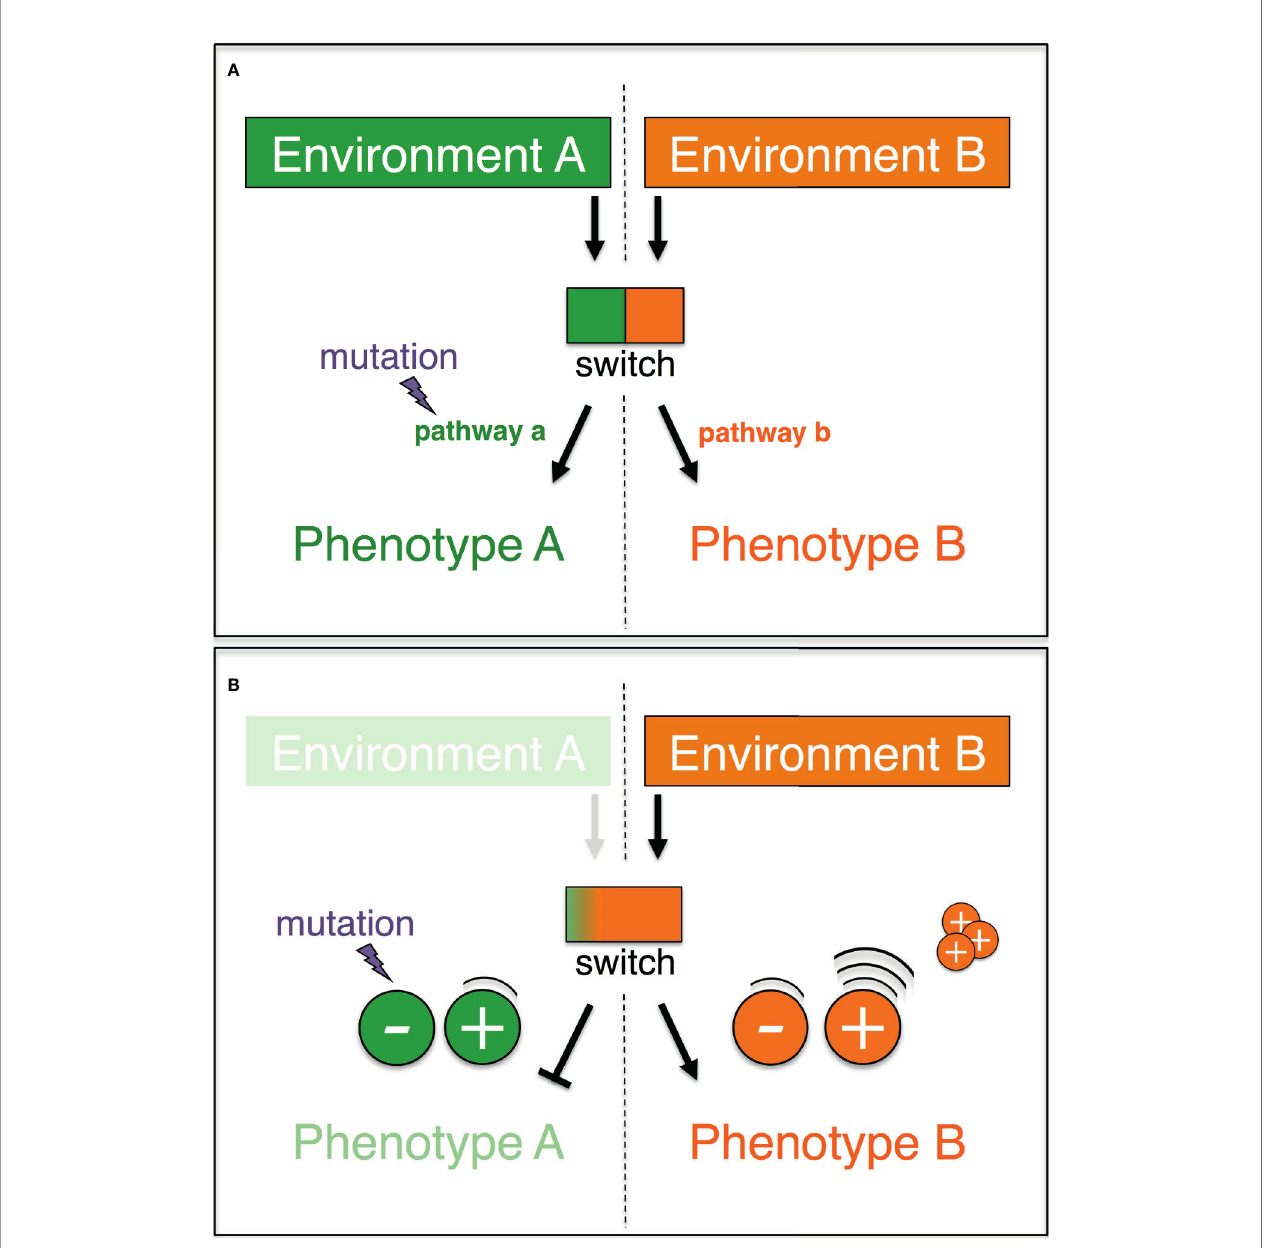
FIGURE 1 | Graphic representation of the plasticity-relaxation-mutation model (Hughes, 2012) and its expanded version (this study). (A) A genetic switch controls the expression of two alternate pathways (a, b) leading, respectively, to two alternate phenotypes (a, b) in response to two different environments (a, b). When environment A is no longer encountered by the organism/cell, there is no longer purifying selection against mutations that eliminate pathway a (modi fi ed after Hughes, 2012). (B) If phenotype A and phenotype B are antagonistically regulated, then the negative molecular regulators of the disfavored phenotype A are redundant and preferentially accumulate mutations. The positive regulators of the adaptive phenotype B are highly expressed, and their copy number may increase as a result of intracellular